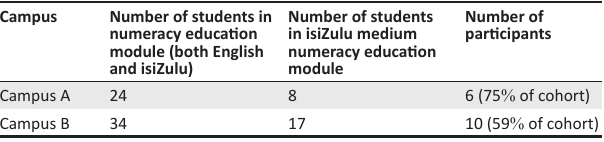
TABLE 1: The number of PGCE pre-service teachers registered for the isiZulu numeracy education module and the number of participants in this study.